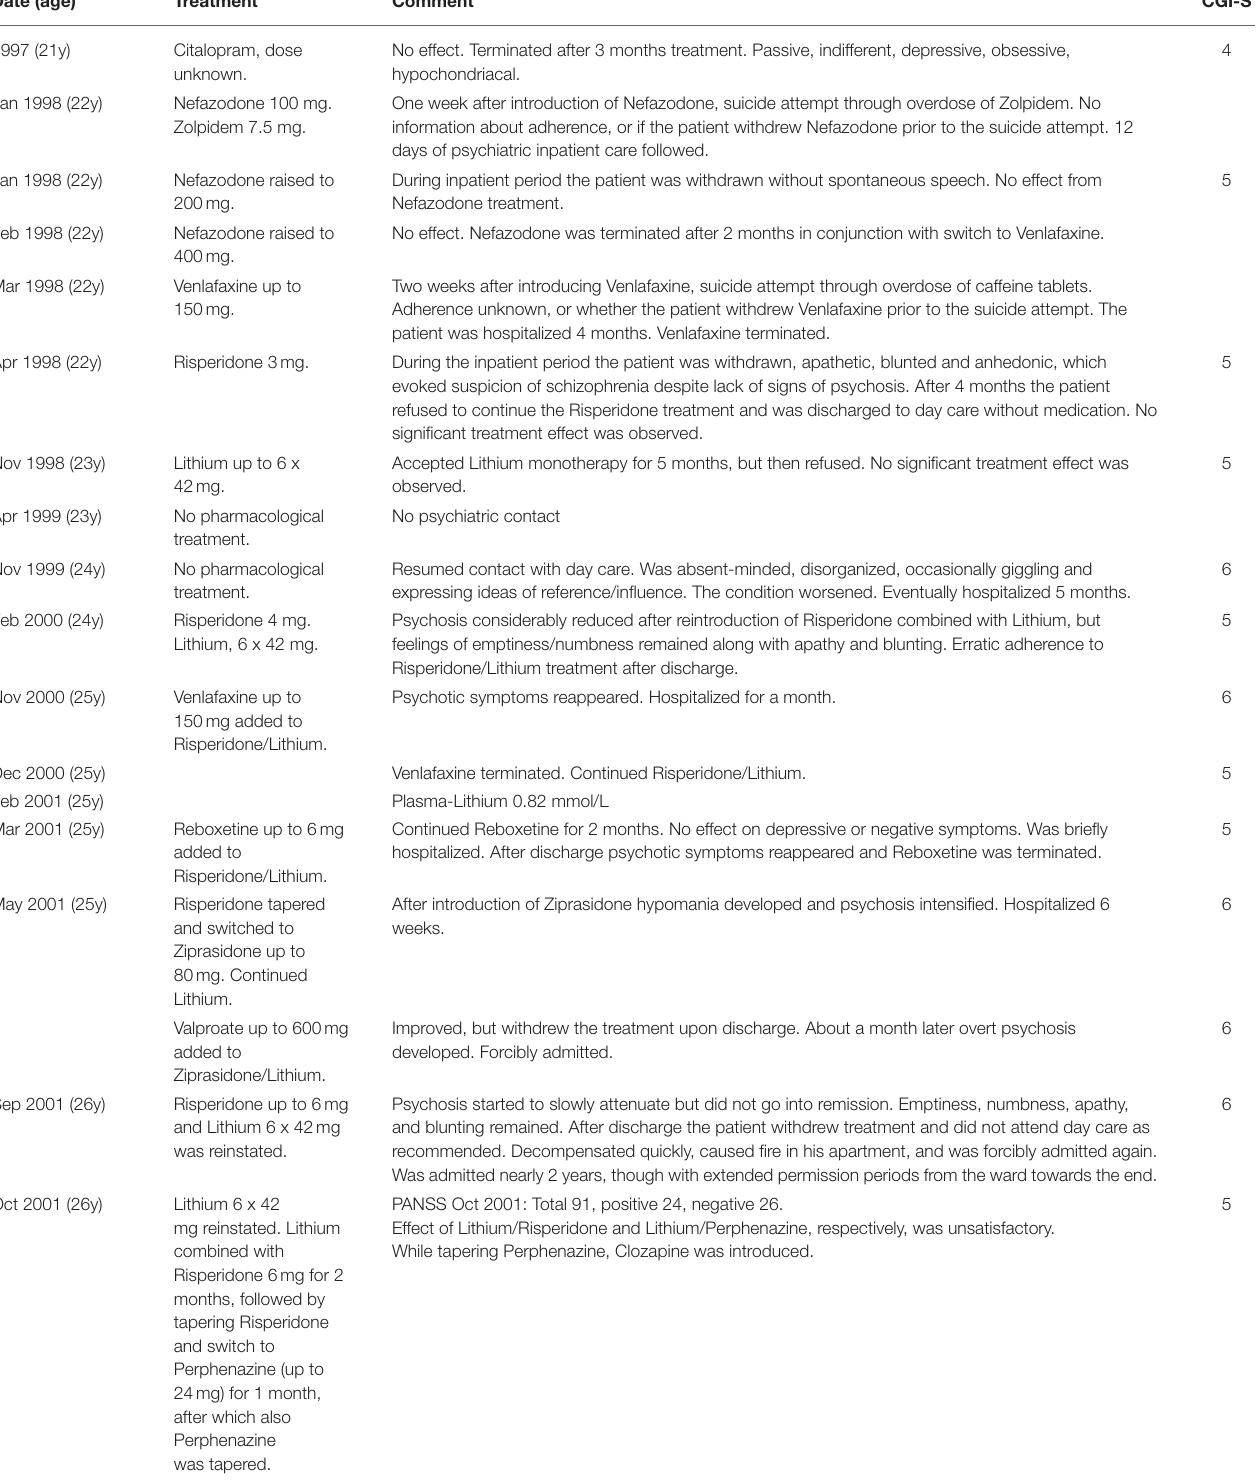
TABLE 2 | Overview of pharmacological treatment history *